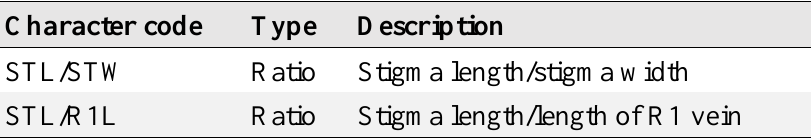
Fig. 1. Analysed characters on a left forewing of Aphidius absinthi female Table 2. List of characters for morphometric analyses.